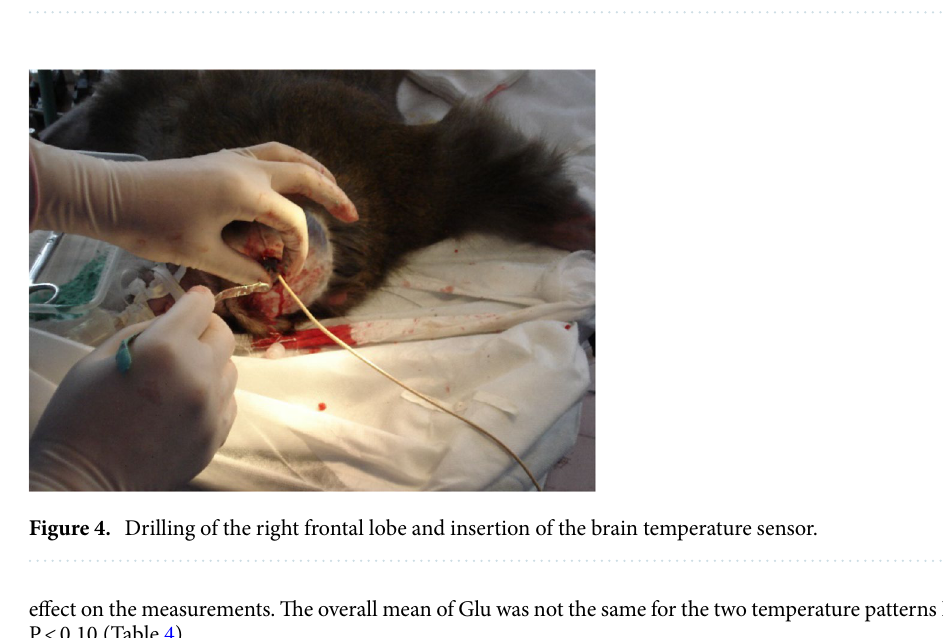
Figure 3. Separation of bilateral femoral arteries and placement of tubes.